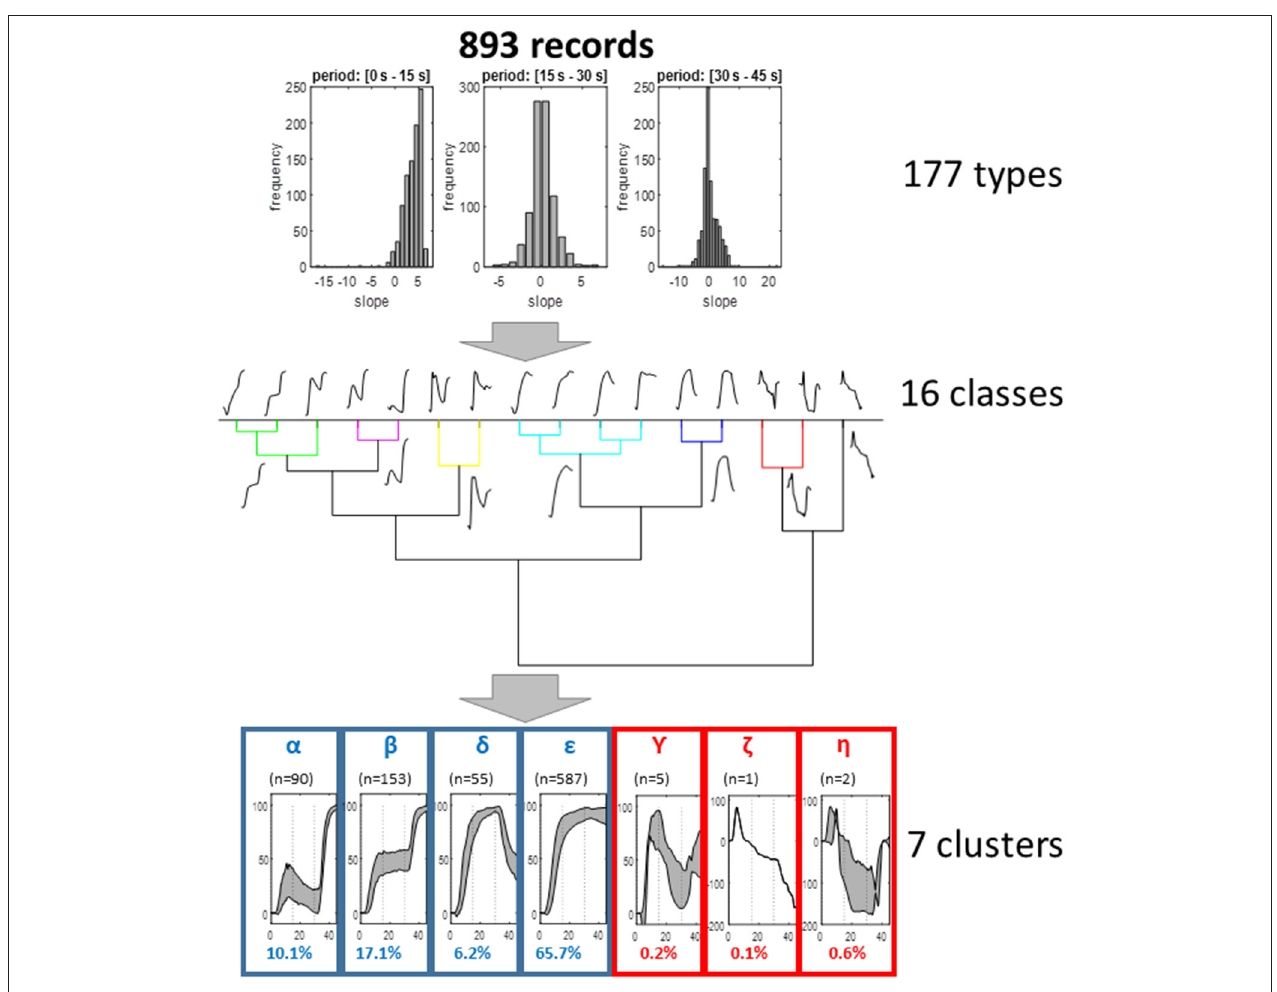
FIGURE 3 | Representation of the different steps of the clustering analysis. As shown, the analysis resulted in seven clusters, four of which allowed the classification of more than 99% of recordings and appeared of clinical interest. For these four clusters, the representation is the interval 25 ◦ and 75 ◦ centile of the different values (gray zone); the other three are mean